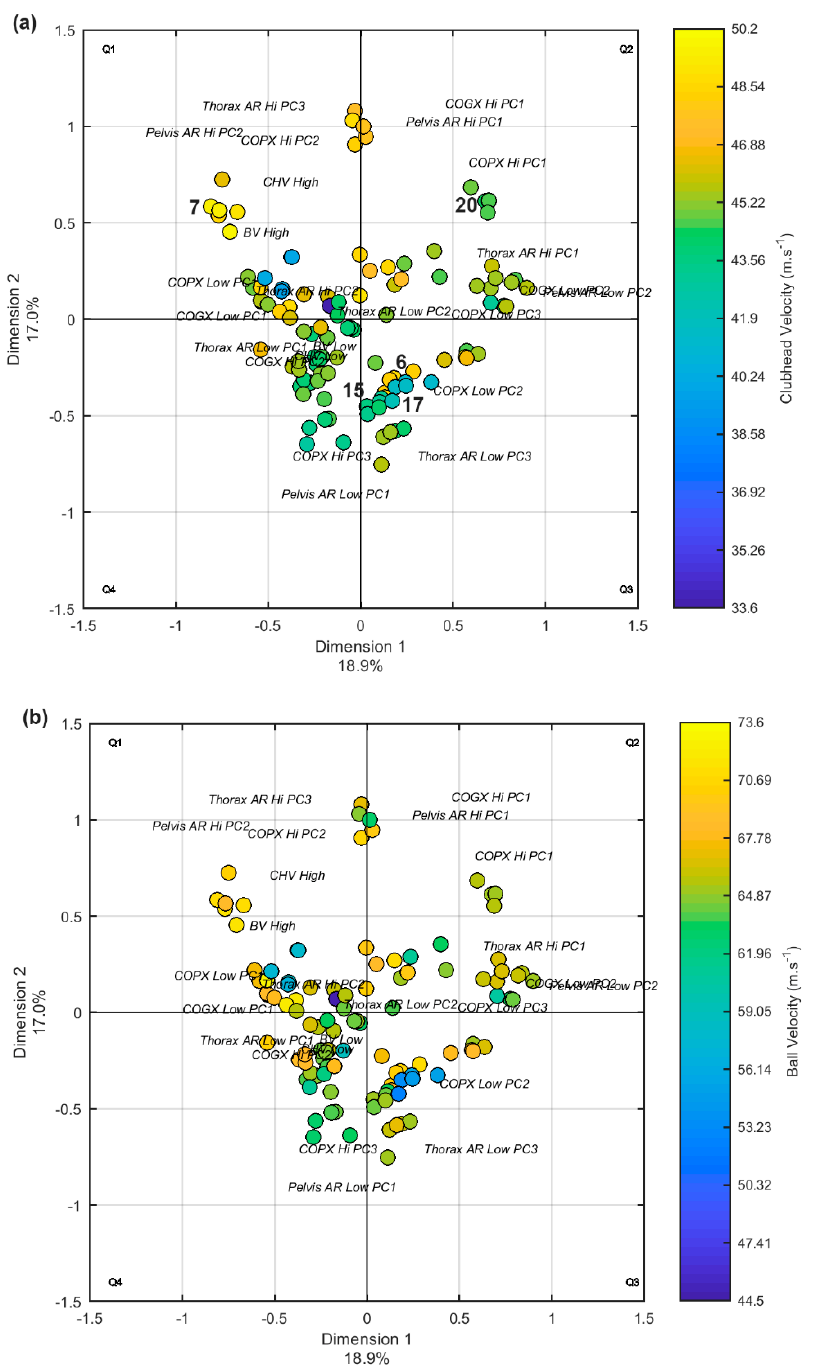
Figure 5. The row points, representing individual golfers and swings, of the first MCA factor plane. Position of individual golfers and their five trials are colour coded according to their ( a ) clubhead velocity and ( b ) ball velocity values.